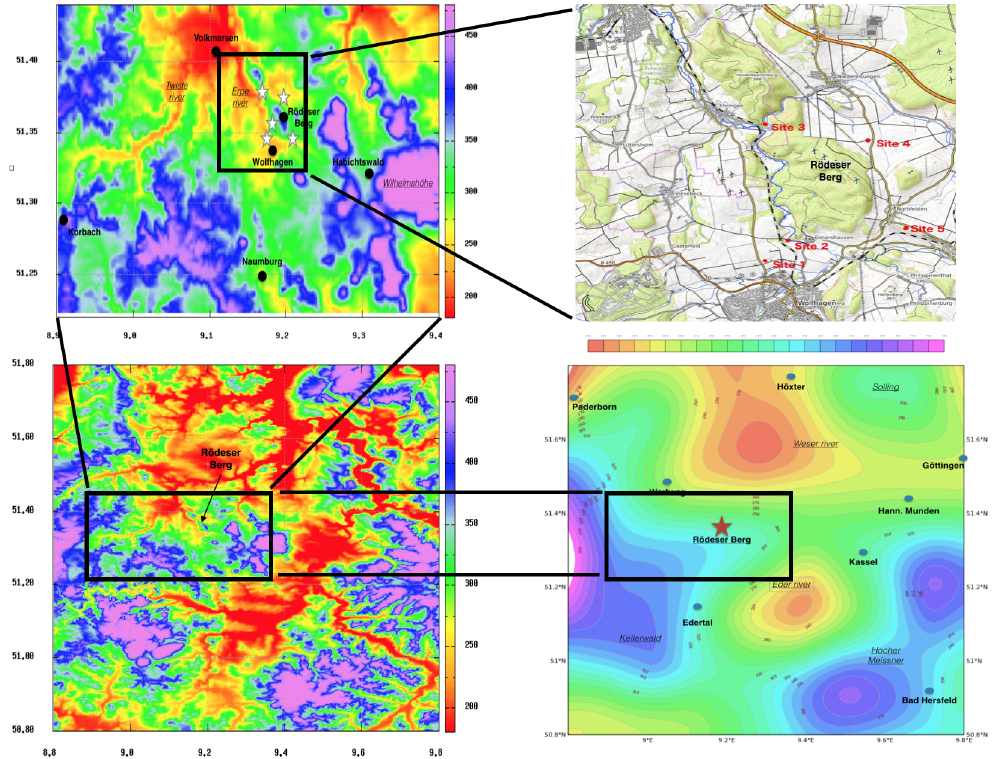
Figure 1. ( Top left ): topography of the area surrounding Rödeser Berg at a resolution of 90 m (approx. 35 km E–W × 25 km N–S); ( top right ): detailed topography and terrain uses at Rödeser Berg (6 km × 6 km), green represents woods; ( bottom left ): topography at a resolution of 90 m in a larger area (approx. 60 km E–W × 80 km N–S); ( bottom right ): the same but at a resolution of 9 km as seen by the European Centre for Medium-Range Weather Forecasts (ECMWF)